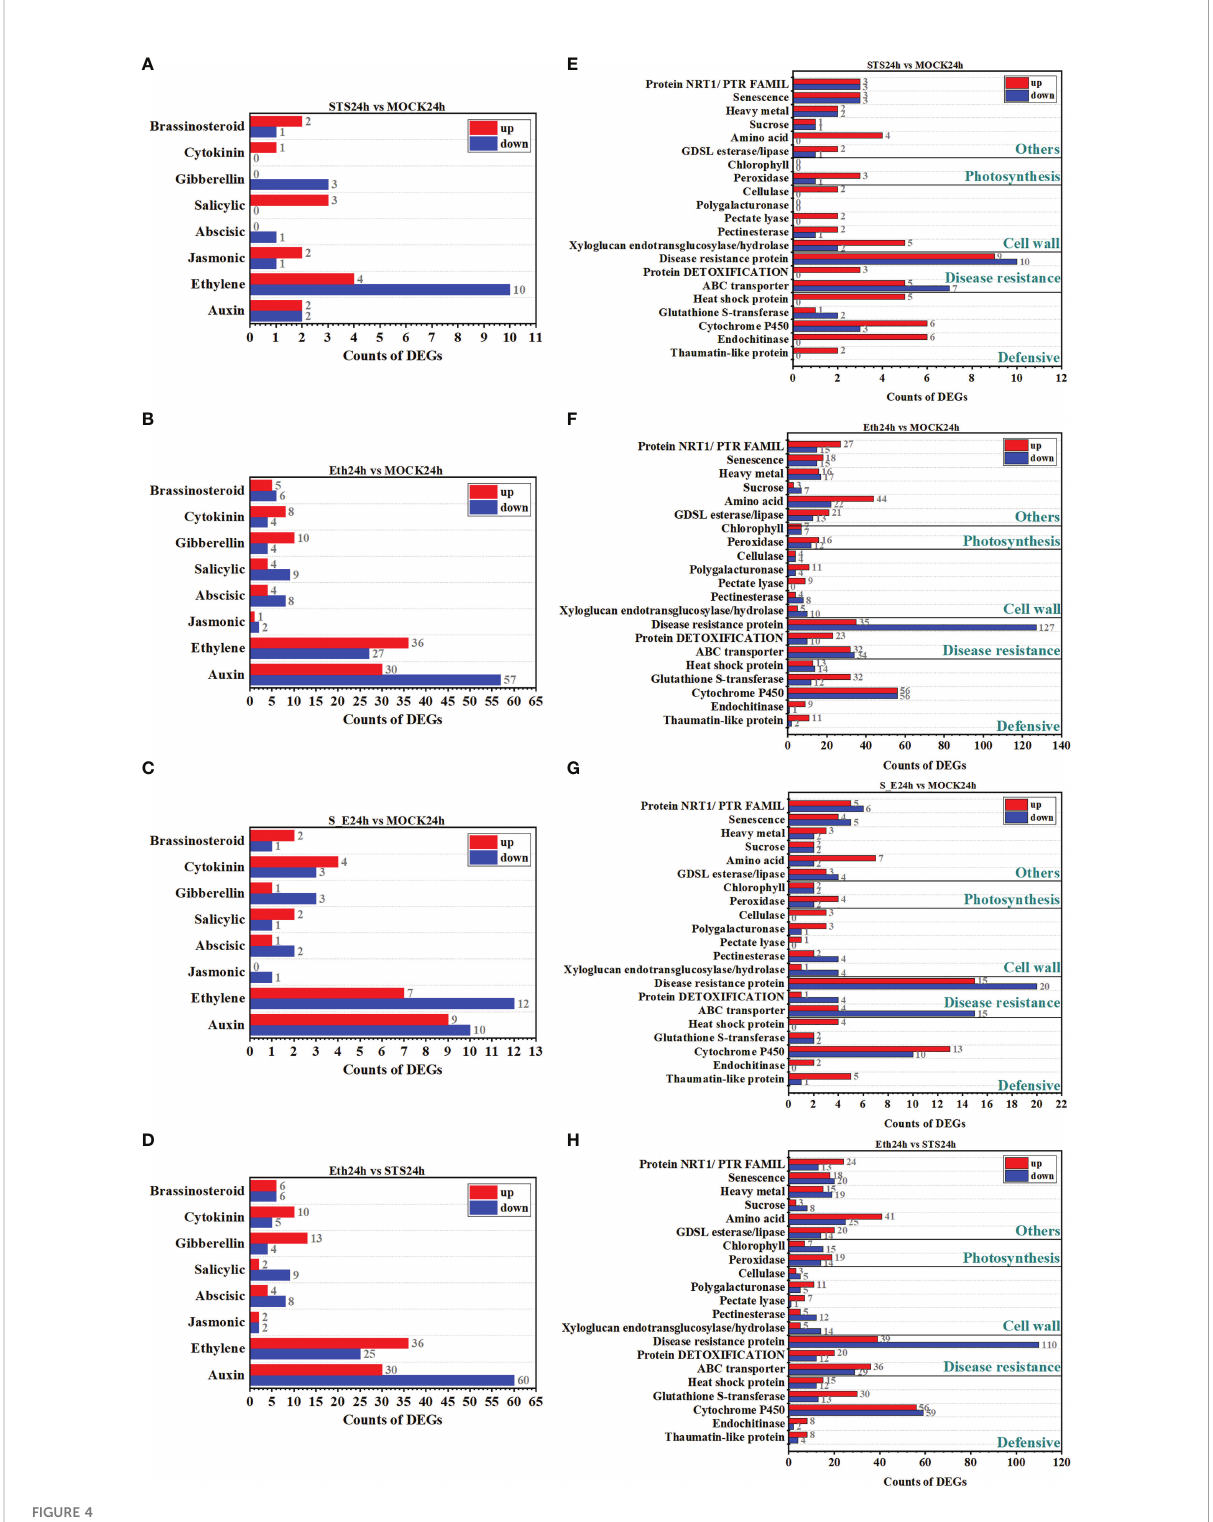
FIGURE 4 Classi fi cation of DEGs. (A – D) Classi fi cation of DEGs related to phytohormone. (E – H) Classi fi cation of different functionally relevant